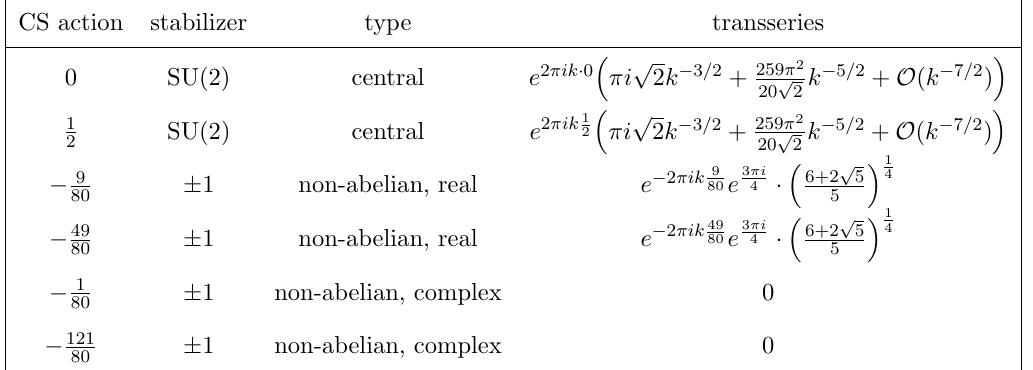
1; 1 ; 1 ; 1 ) = S 3 ( 4 1 ) up to an +2 2 4 5 (cid:0)